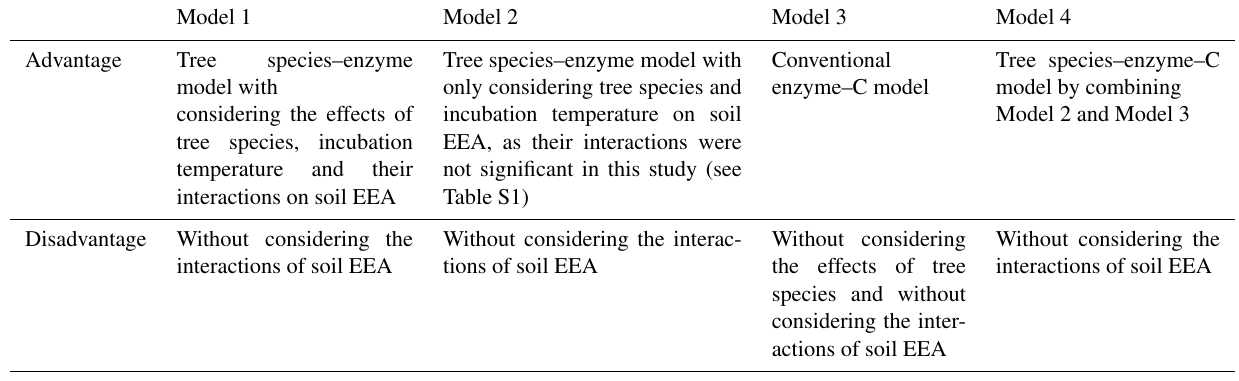
Table 2. Description and comparison of the four models used in this study. EEA, extracellular enzyme activities.